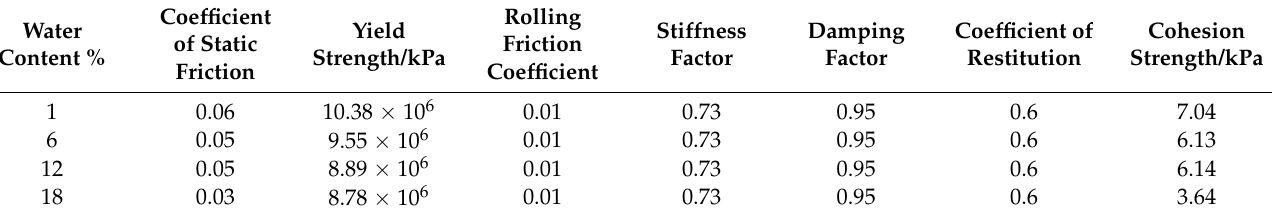
Table 1. Predicted simulation parameters of sandy loam.